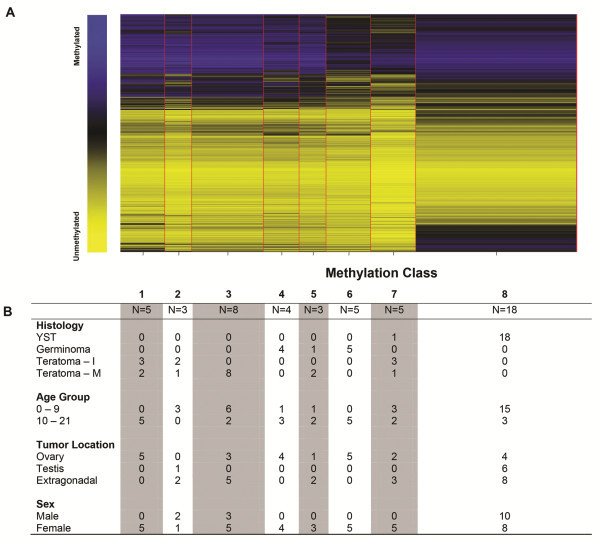
Recursively partitioned mixture model (RPMM) of CpG methylation in GCTs. A. Columns represent methylation class generated by RPMM and rows represent the average methylation within the class at each CpG site. Blue represents methylated and yellow represents unmethylated. The width of the row is proportional to the number of samples included in the methylation class. B. Characteristics of the tumors in each methylation class.